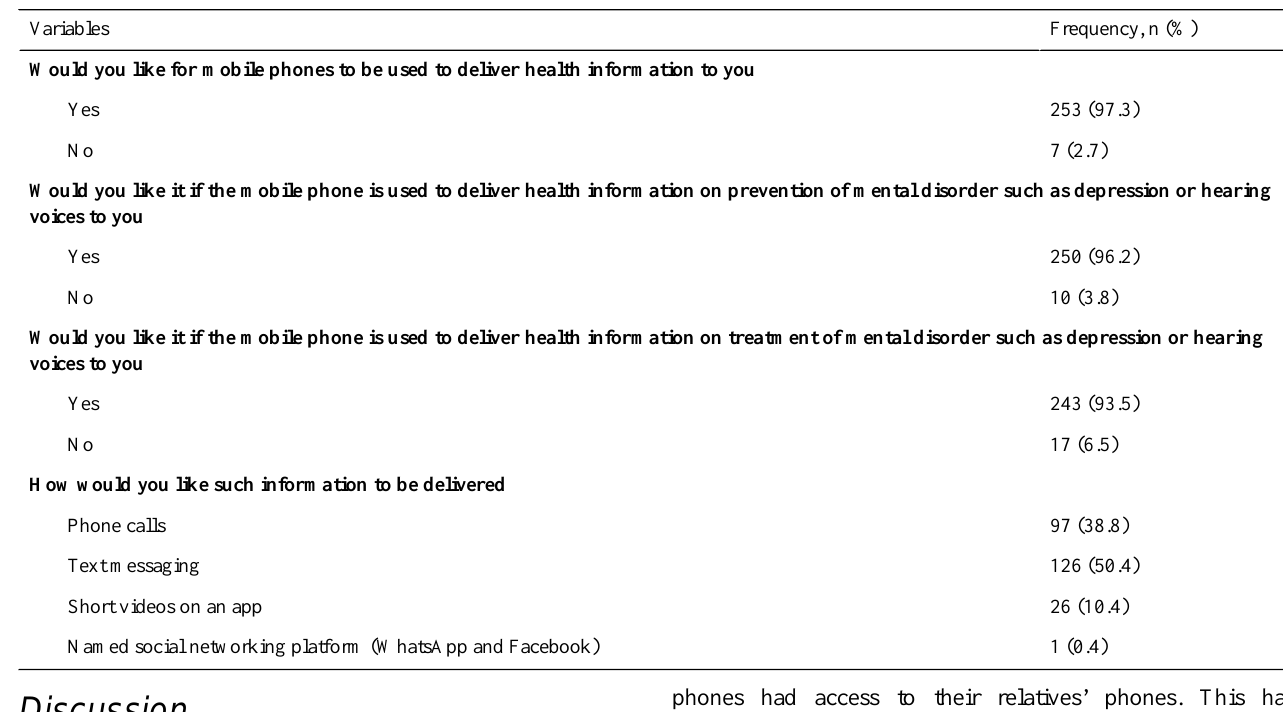
Table 3. Perinatal adolescents’interest in mHealth (N=260).